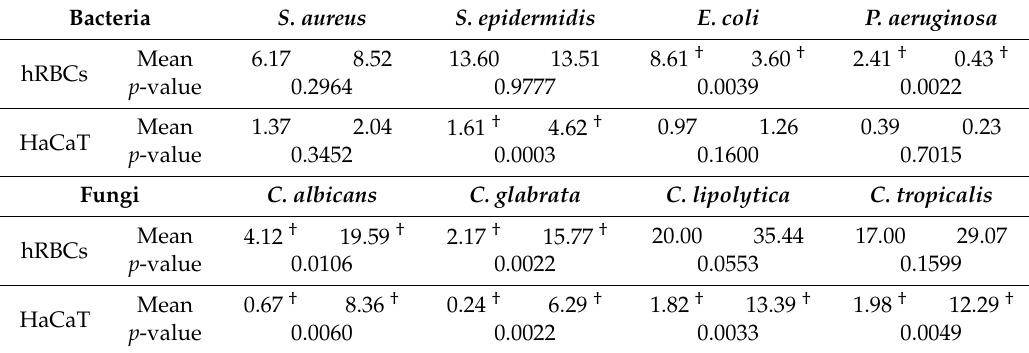
Table 6. Analysis of selectivity indexes (left—linear, right—cyclic